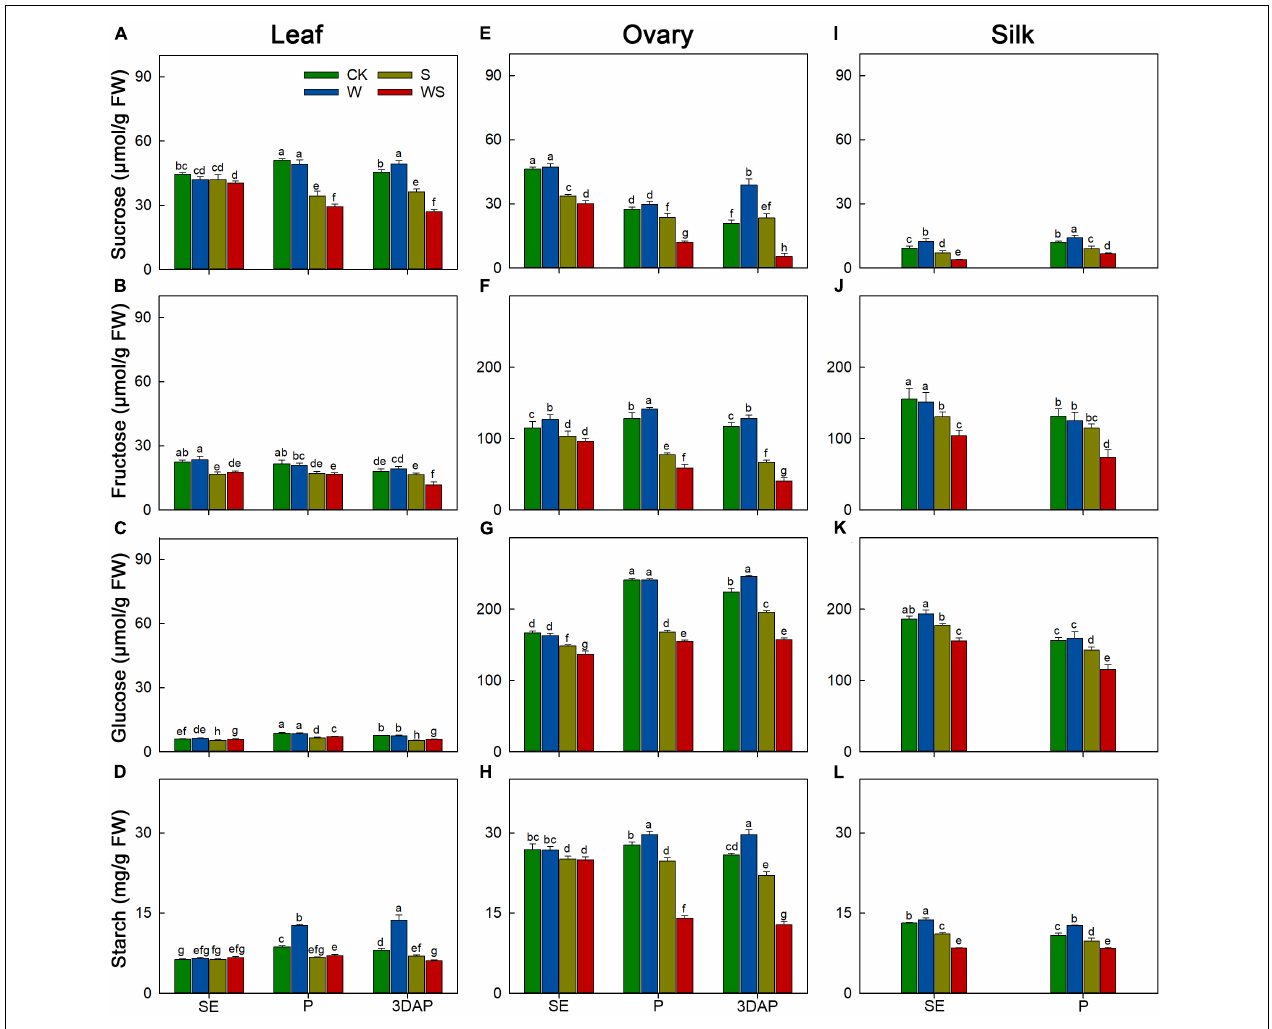
FIGURE 3 | Changes in the contents of sucrose, fructose, glucose, and starch in leaf (A–D) , ovary (E–H) and silk (I–L) at SE (first silk emergence), P (full silk emergence), and 3DAP (3 days after pollination) in control (CK), waterlogging + shading (WS), waterlogging (W), and shading (S) treatment groups. Data were subjected to one-way ANOVA followed by Duncan’s new multiple range test ( n = 3). Different letters above bars indicate significant differences ( P < 0.05). Error bars represent ±